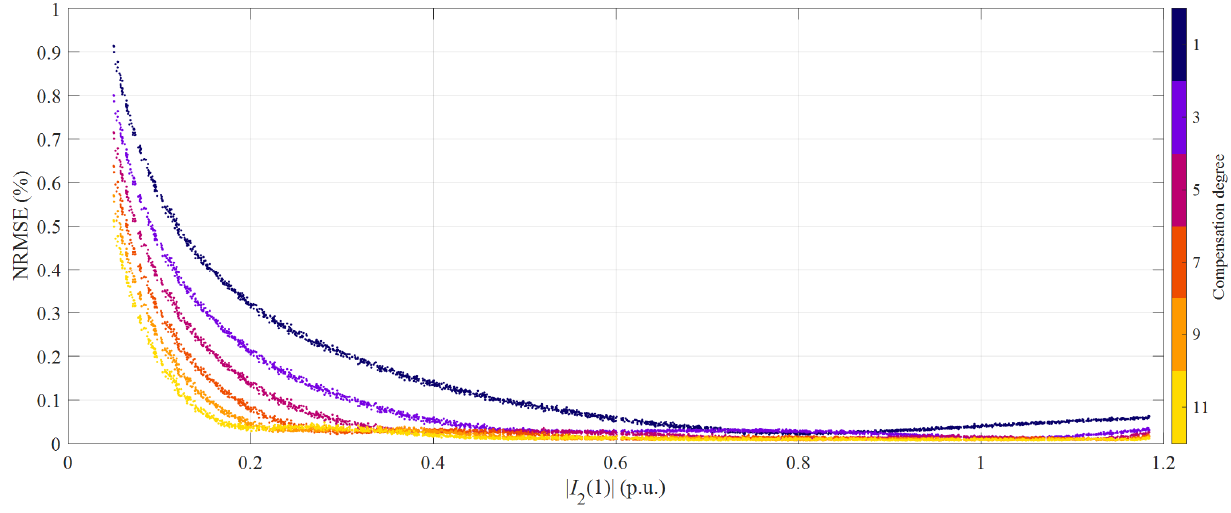
Figure 7. NRMSE as a function of the fundamental secondary current magnitude for different HD compensation degrees; transformer CT1, class E 1 of primary current waveforms.